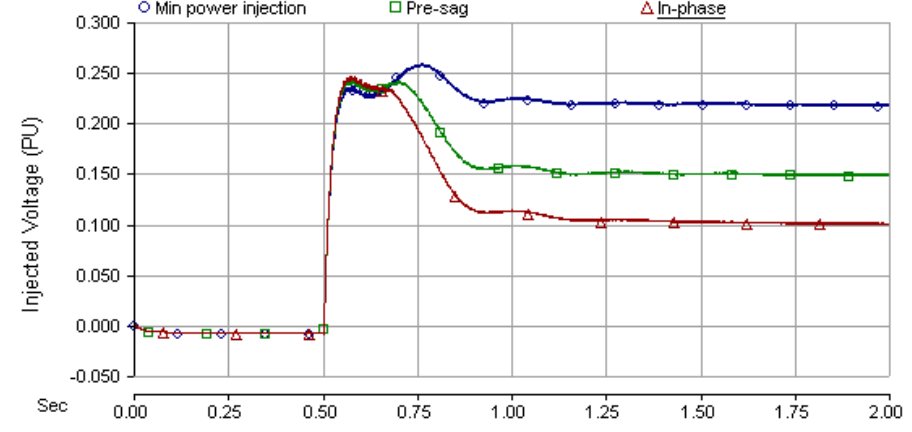
Figure 6. Comparison of DVR-injected voltage in the minimum power injection, pre-sag, and in-phase compensation strategies.